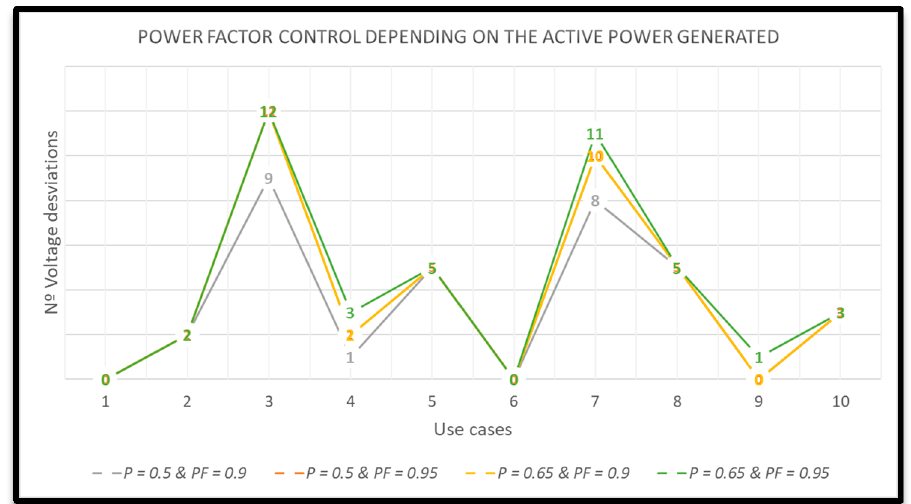
Figure 11. Power factor control depending on the active power generated: Voltage deviations (More information see Table A8 in Appendix C).